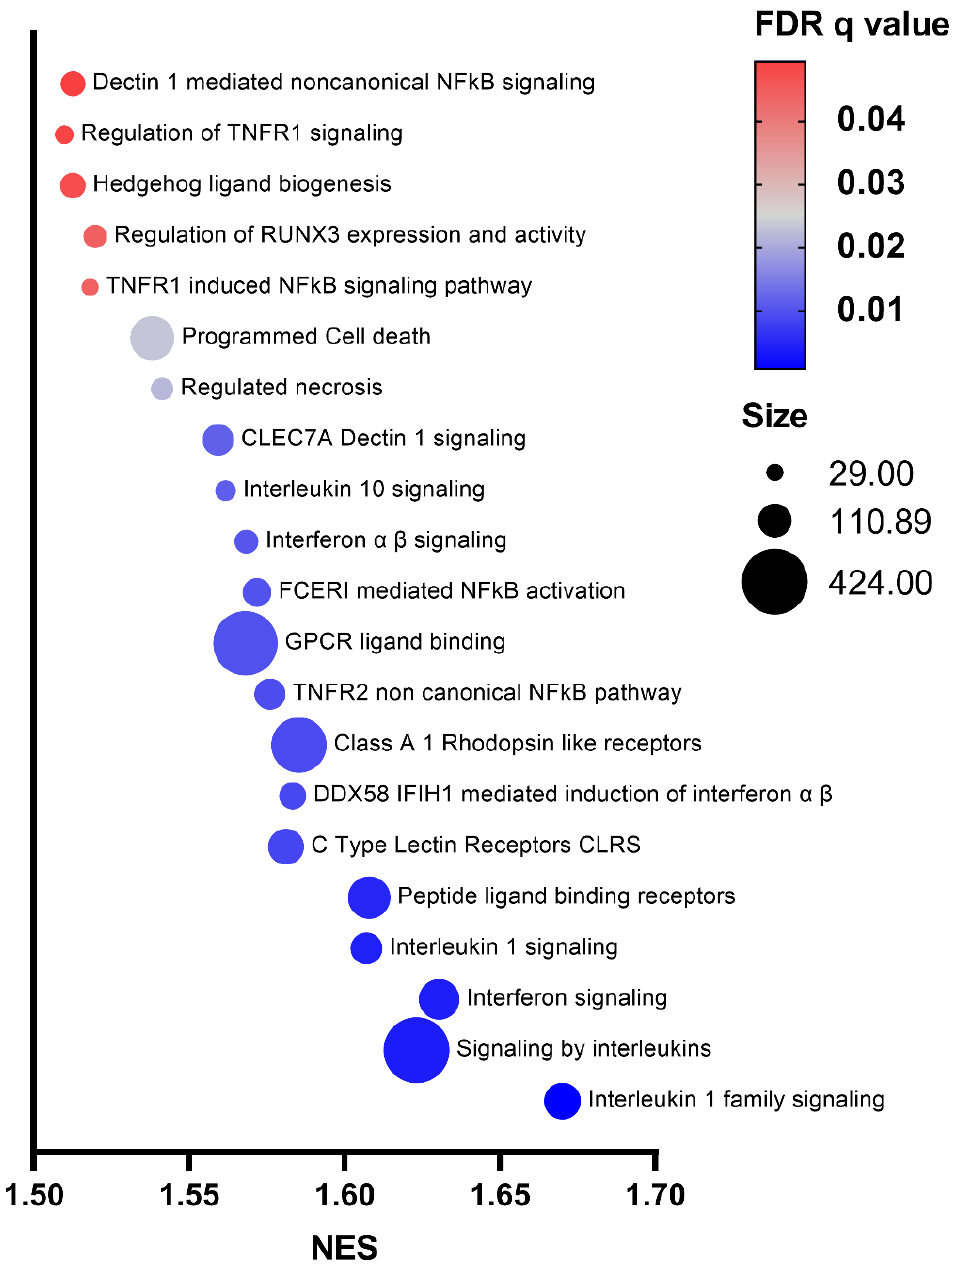
Figure 4. List of pathways emerged from GSEA analysis of Group 1 and Group 2 BMDMs. Bubble plot of the top 21 significant Reactome pathways (FDR q -value < 0.05) enriched in Group 1 macrophages as determined by GSEA analysis. The X -axis represents the normalized enrichment score (NES) and Y -axis indicates enriched pathway terms. Bubble area is proportional to the size of the gene set. Bubble color indicates the FDR q -value.